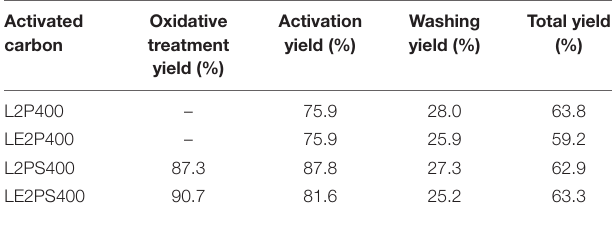
TABLE 2 | Yield values of the lignin activated carbons.